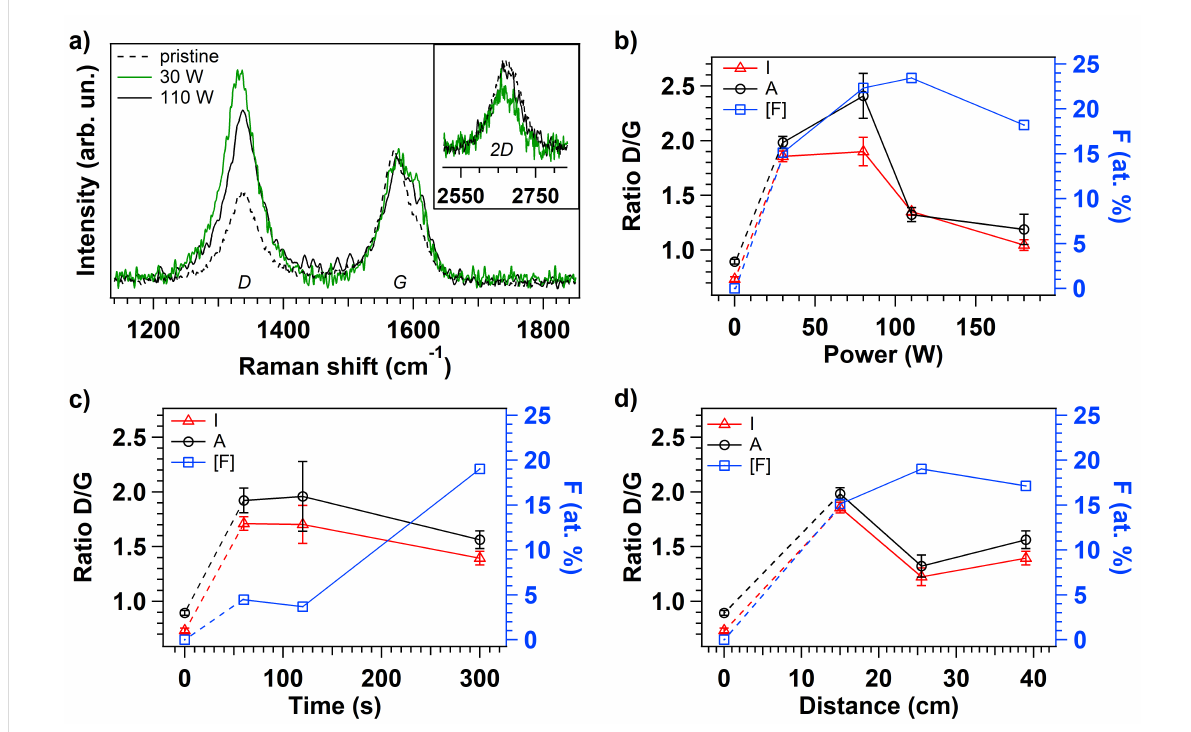
Figure 4: Representative Raman spectra of pristine and fluorinated vCNT (a). Evolution of intensity ( I ) and area ( A ) ratios calculated from D and G peaks in the Raman spectra for each fluorinated sample after plasma treatment at different power (b), time (c) and distance of the sample from the plasma region